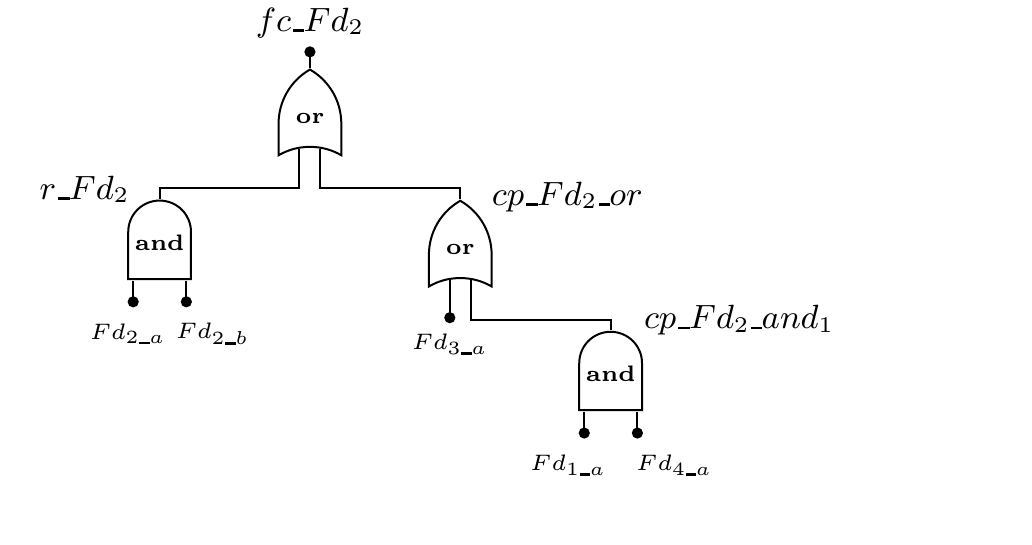
Algorithm 1: Algorithm to generate all paths between a device and the gateway. Algorithm: DFS( Paths , Device , Current Path